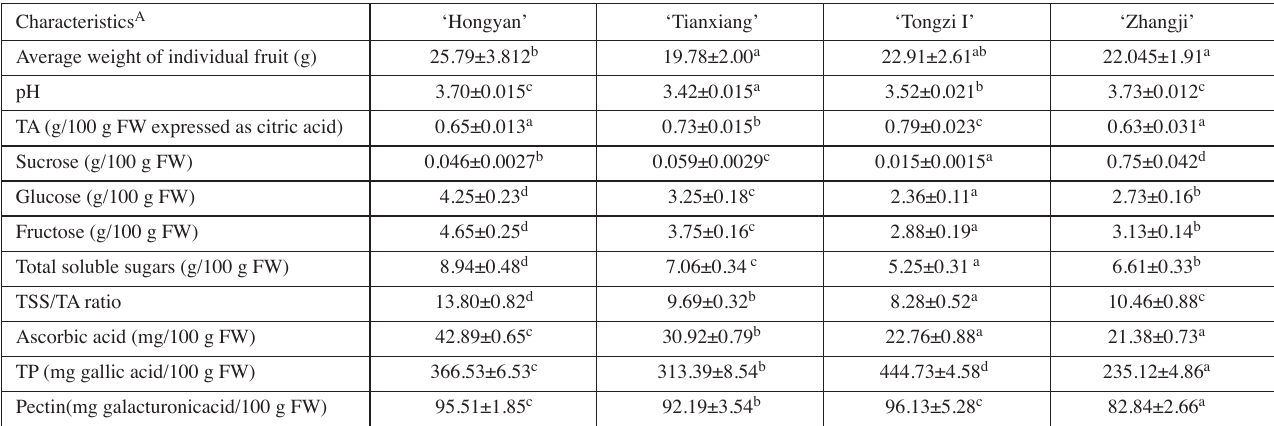
Tab. 1: Basic physico-chemical characteristics of selected four cultivars of strawberries. Characteristics